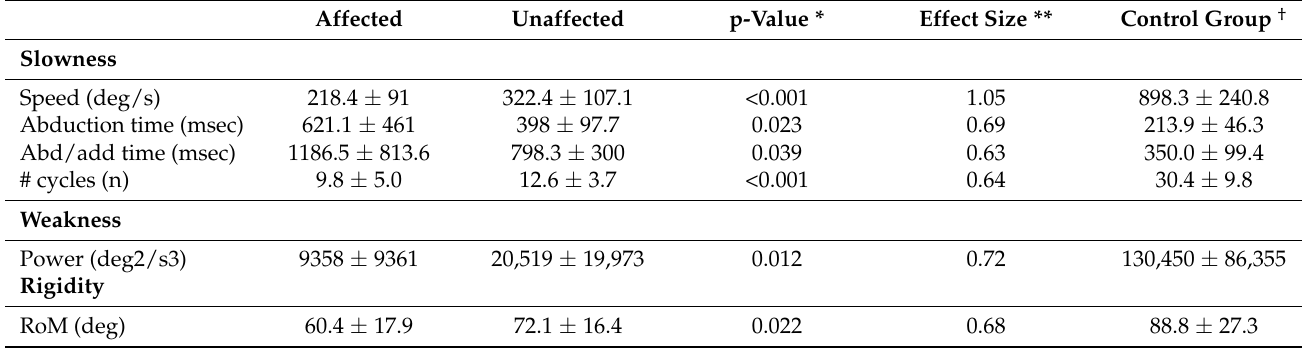
Table 3. Digital biomarkers of nTOS severity. Affected and unaffected extremities of nTOS patients were compared. Shown are the variables that achieved statistical significance. Values for the dominant extremity of the control group are included as reference healthy